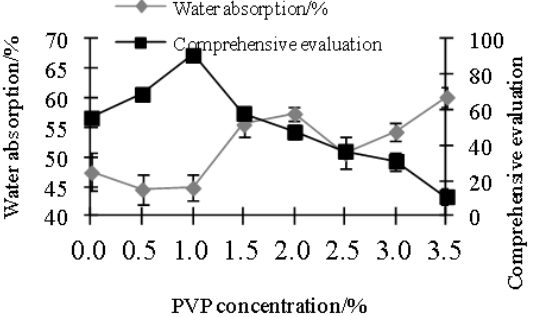
Figure 3. Effects of PVP concentration on tensile strength and elongation rate.